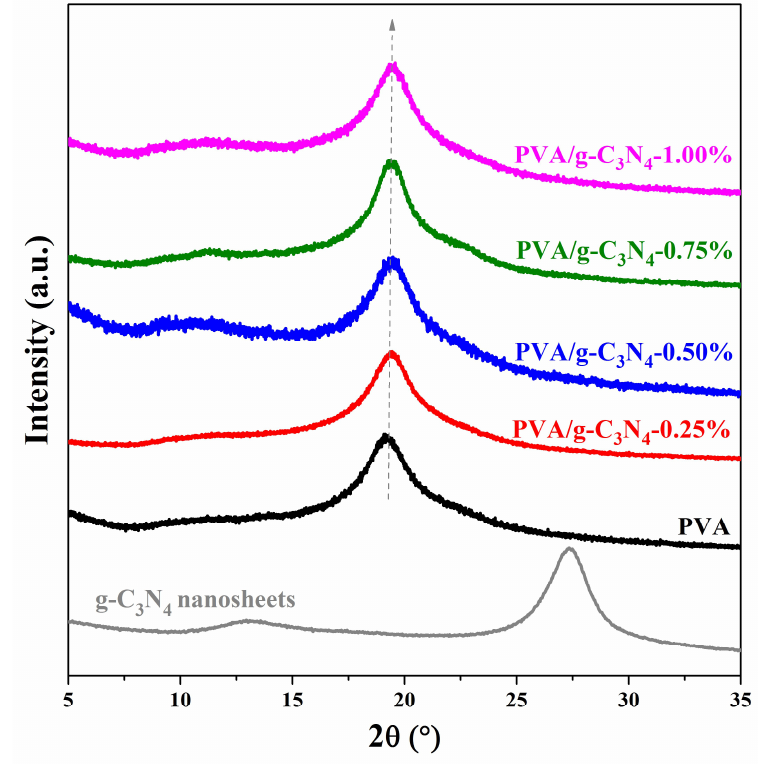
Figure 5. XRD curves of PVA/g-C 3 N 4 nanocomposites with various g-C 3 N 4 contents.